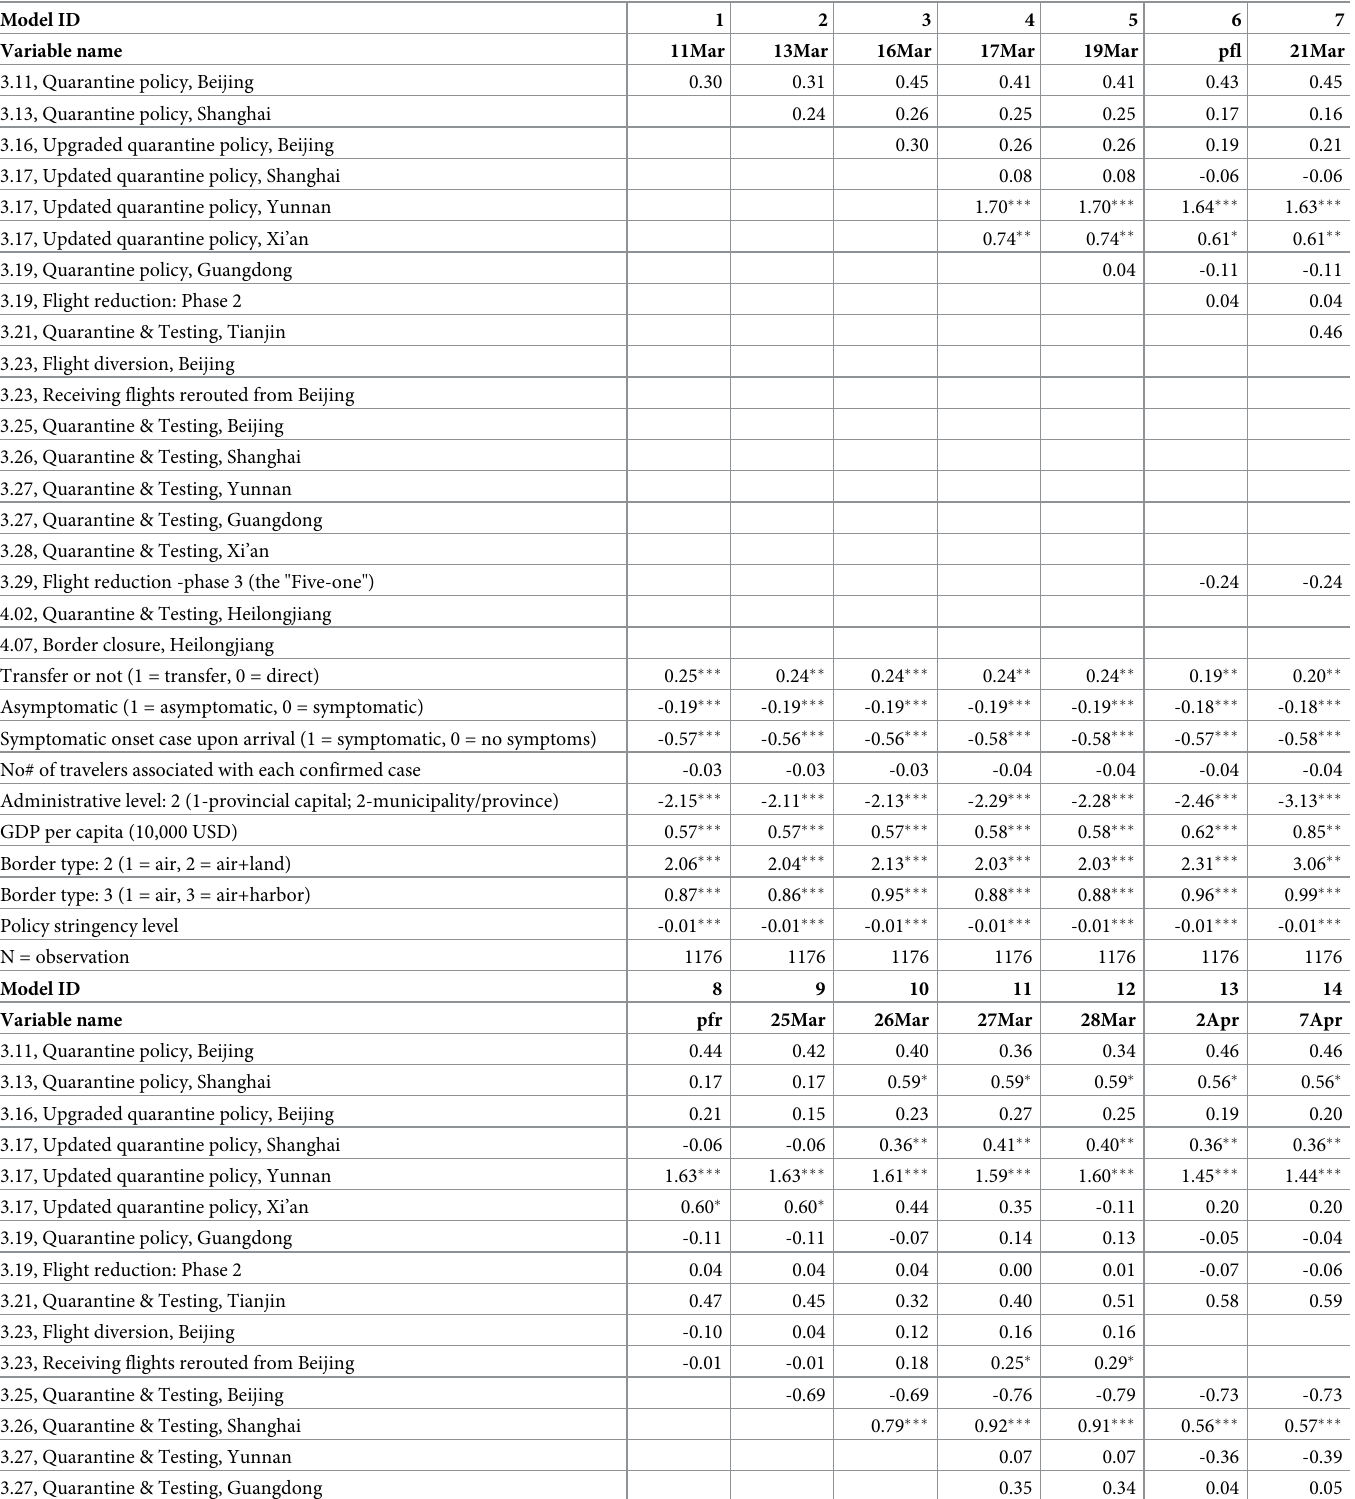
Table 1. Marginal effects of the time interval of case confirmation to the synchronized effect of multi-dimensional policies with multiple controls. Model